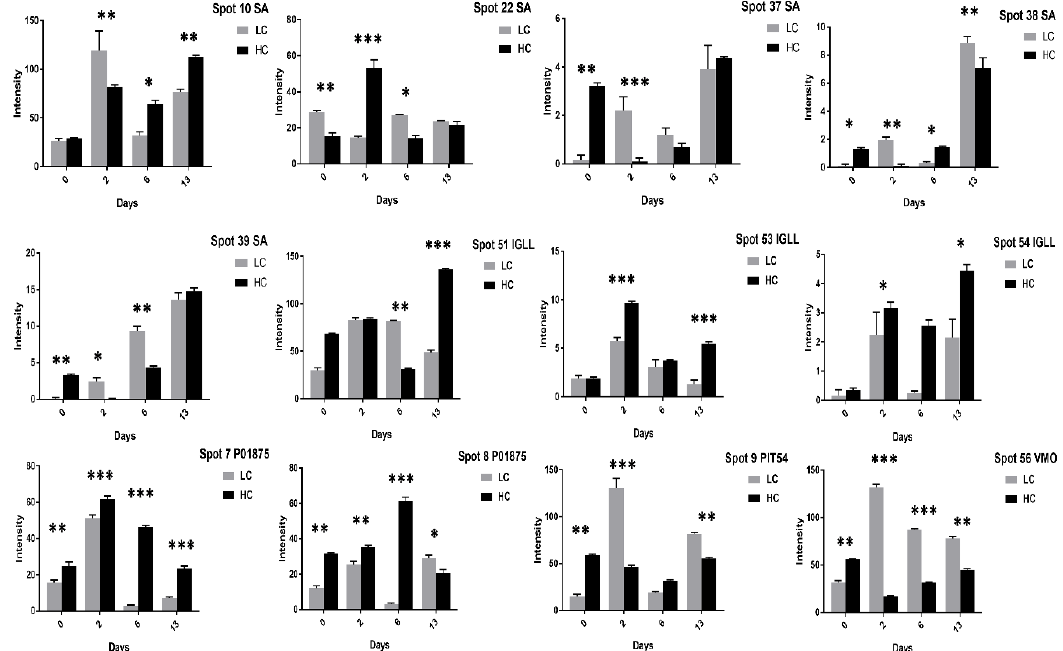
Figure 15. The SA, IGLL, P01875, PIT54, and VMO1 protein intensities were compared in high and low cholesterol eggs at 0, 2, 6, and 13 days of incubation. The column profiles of SA (10, 22, 37–39), IGLL (51, 53, 54), P01875 (7, 8), PIT54 (9), and VMO (56) are shown as bar charts with significant differences. The values are from three independent replicates and the error bars represent the standard deviation. * p < 0.05, ** p < 0.005, *** p < 0.0001. Table 2. The table showed the egg quality parameters and cholesterol amount determined in egg yolk in low and high cholesterol eggs.